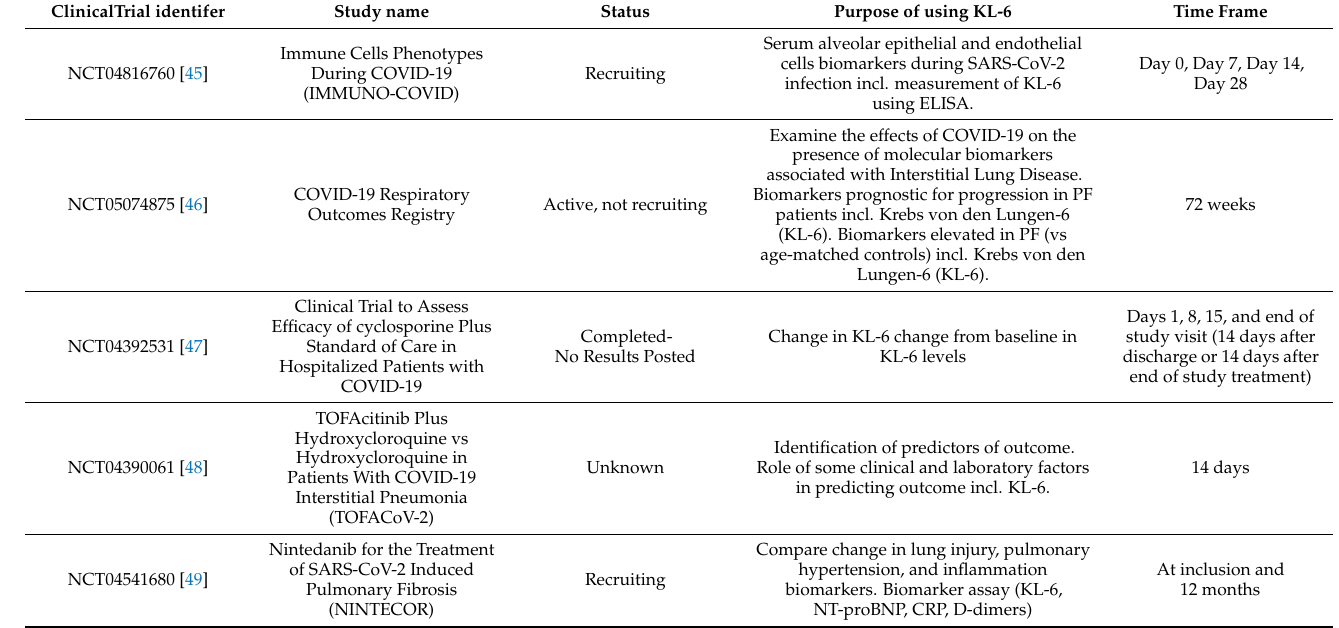
Table 2. Currently ongoing research on KL-6 in the context of COVID-19